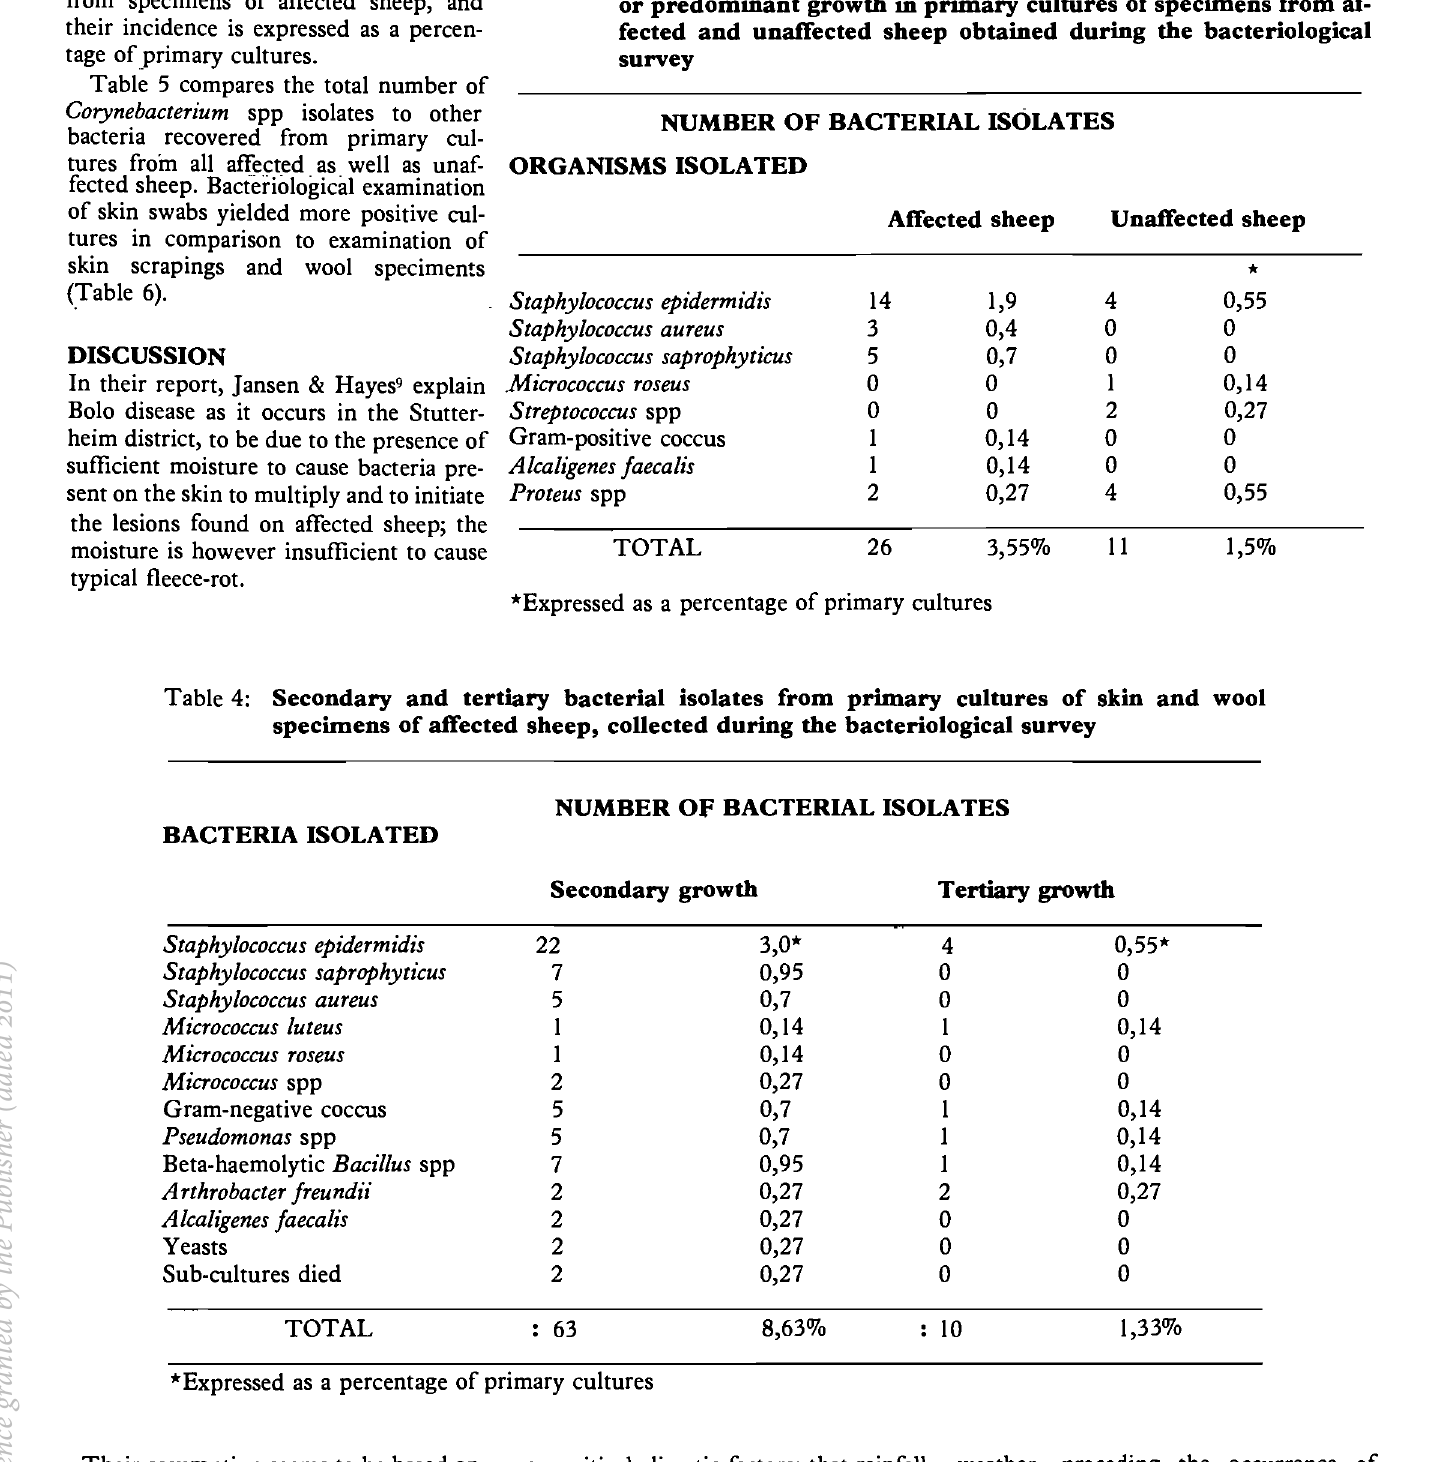
Table 4: Secondary and tertiary bacterial isolates from primary cultures of skin and wool specimens of affected sheep, collected during the bacteriological survey NUMBER OF BACTERIAL